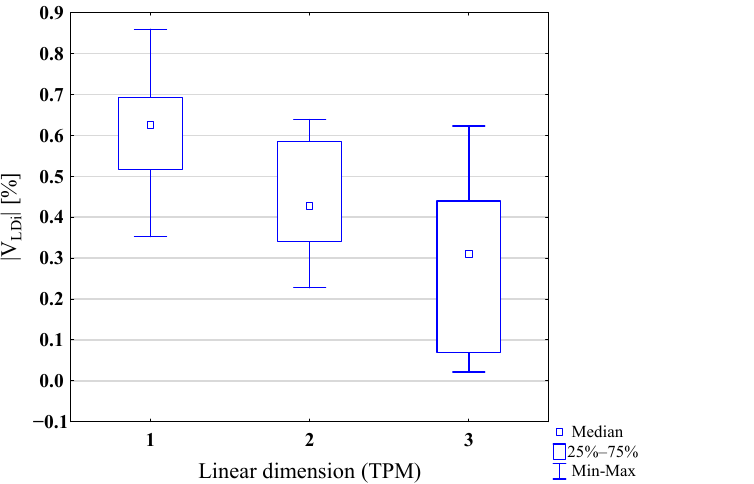
Figure 10. Distribution of absolute values of the VLDi coefficient for the examined linear dimen- sions (TPM).